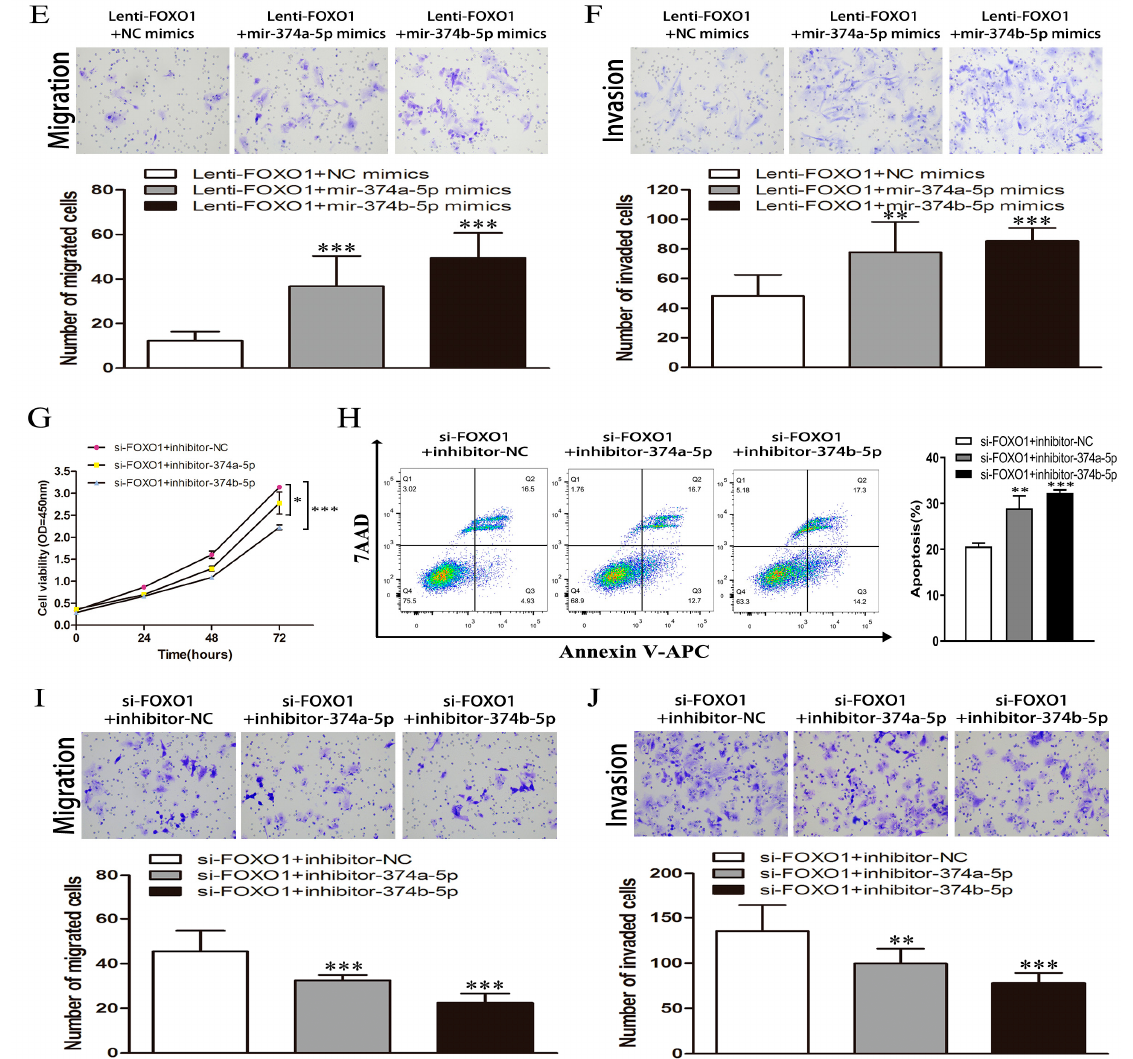
Figure 10. ( A ) the mRNA of FOXO1 overexpression in HepG2 cells combined with miR-374a/b-5p mimics significantly reduced FOXO1 expression compared with FOXO1 overexpression with NC mimic treated cells, and the mRNA of FOXO1 expression in HepG2 cells transfected with si-FOXO1 was significantly increased due to co-transfection of inhibitor-374a-5p or inhibitor-374b-5p. ( B ) The protein of FOXO1 overexpression in HepG2 cells combined with miR-374a/b-5p mimics significantly reduced FOXO1 expression compared with FOXO1 overexpression with NC mimic treated cells, and the mRNA of FOXO1 expression in HepG2 cells transfected with si-FOXO1 was significantly increased due to co-transfection of inhibitor-374a-5p or inhibitor-374b-5p. ( C ) FOXO1 overexpression combined with miR-374a/b-5p mimics significantly increased the viability of proliferation of HepG2 cells compared with FOXO1 with NC mimic treated HepG2 cells. ( D ) The apoptosis rate of stably transfected HepG2 cell lines overexpressing FOXO1 was reduced by transfection of miR-374a/b-5p mimics. ( E , F ) A transwell test showed that transfection of miR-374a/b-5p mimics the offset effect of suppressing FOXO1 overexpression on migration and invasion of HepG2 cells. ( G ) Transfection of inhibitor-374a-5p and inhibitor-374b-5p offset the proliferation-promoting effect of knocking down FOXO1 on HepG2 cells. ( H ) The apoptosis rate of HepG2 cells transfected with si-FOXO1 was significantly increased due to the co-transfection of inhibitor-374a-5p or inhibitor-374b-5p. ( I , J ) Transfection of inhibitor-374a-5p and inhibitor-374b-5p offset promoting effect of FOXO1 knockdown on HepG2 cell migration and invasion. * p < 0.05, ** p < 0.01, *** p < 0.001. FOXO1, Forkhead Box O1. QRT-PCR: quantitative real-time polymerase chain